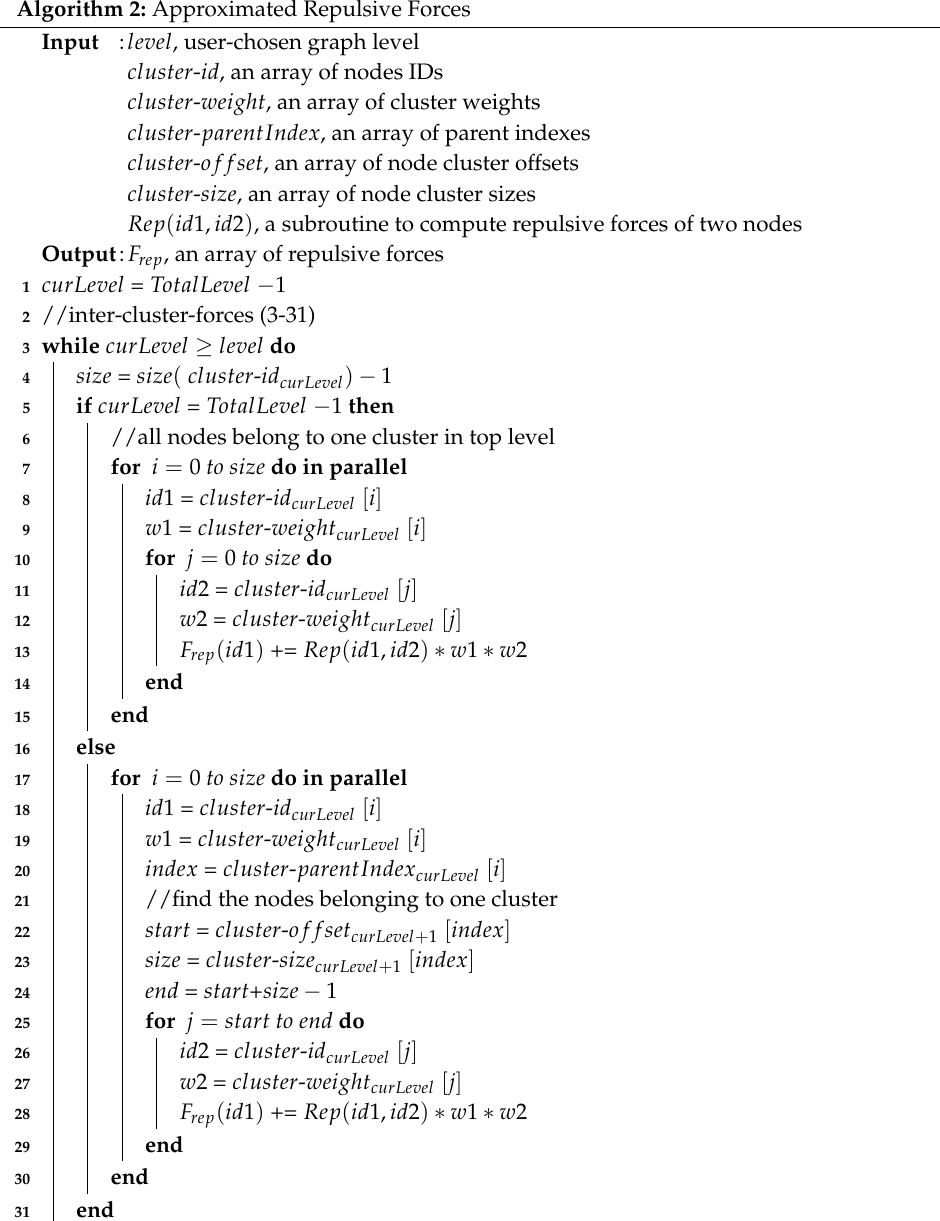
Algorithm 2: Approximated Repulsive